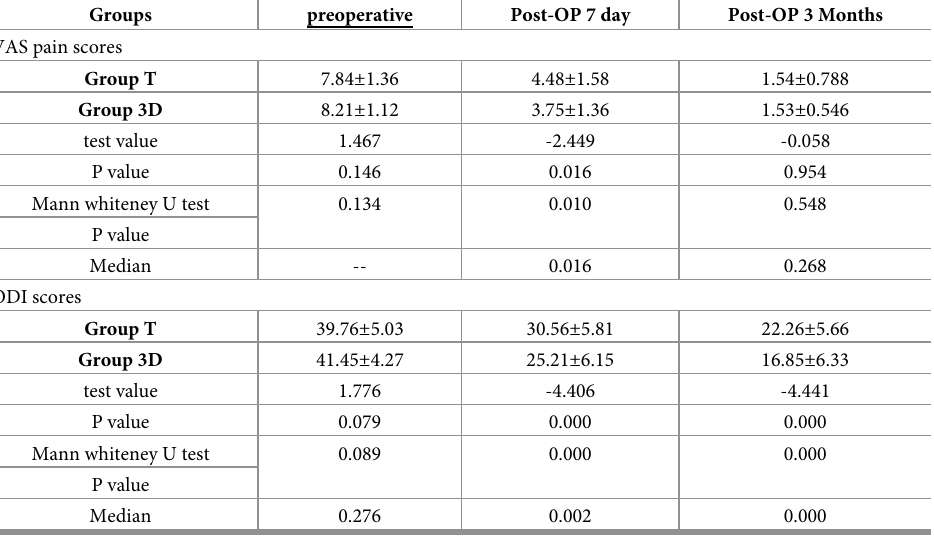
Table 3. VAS pain and ODI scores.